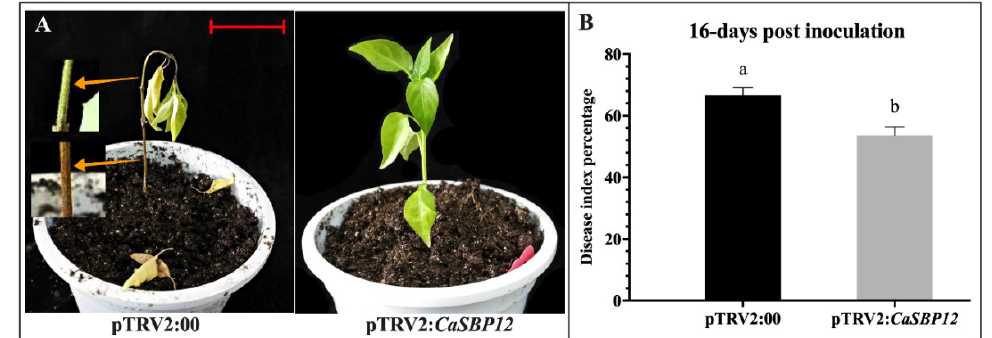
Figure 8. Phenotypes and disease index percent of the silenced and control plants after inoculation with the HX-9 strain of P. capsici. ( A ) Phenotypes of the silenced and control plants after inoculation with the HX-9 strain of P. capsici . The two yellow arrows indicated the constricted area of the stem. ( B ) Disease index percent of the silenced and control plants after being inoculated with the HX-9 strain of P. capsici . Photographs and disease index percent were counted and taken at 16-day post-inoculation, respectively. The red line is used as a scale bar (length 3 cm). Bars with different lower-case letters indicate significant differences using the least significant difference (LSD) value ( p ≤ 0.05). Mean values and SEs are shown.